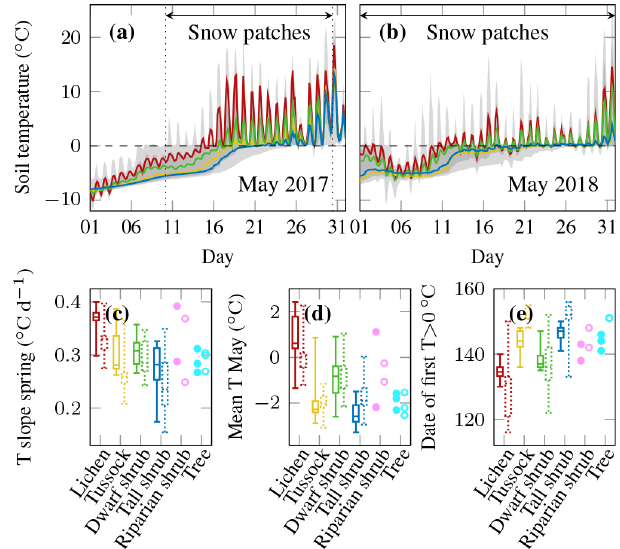
Figure 8. Topsoil temperature series of (a) May 2017 and (b) May 2018 representing spring of the two different measurement periods; mean of all measurements below four different vegetation types is shown in colour, the range of all single sensors is shown in light grey, and the range of all sensors between the 10th and 90th percentiles is shown in darker grey; box plots of all measurements per vegetation type are represented by boxes of the first period on the left and the second period on the right and dotted; for riparian shrubs and trees all single observations are shown with filled sym- bols for the first period and open symbols for the second; (c) rate of warming in spring; (d) mean May temperature; (e) date when thawing is